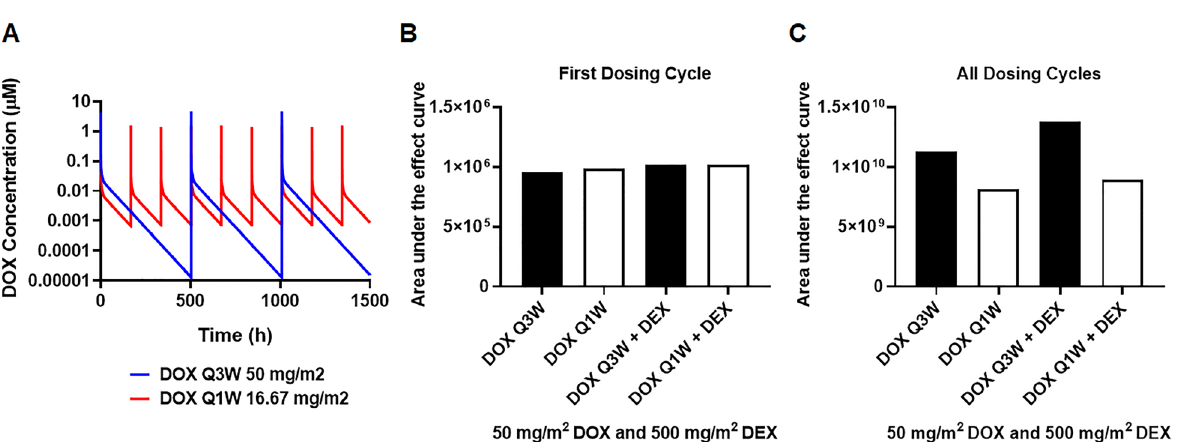
Figure 4. ( A , B ) Model simulations for doxorubicin (DOX) clinical pharmacokinetics over three dosing cycles ( A ) and one dosing cycle ( B ) at indicated dose levels. ( C , D ) Model simulations for dexrazoxane (DEX) clinical pharmacokinetics over three dosing cycles ( C ) and one dosing cycle ( D ) at indicated dose levels. ( E ) Area under the effect (cell viability) curves for 50 mg/m 2 DOX administered once every three weeks for three dosing cycles in the presence of varying DEX:DOX dose ratios as indicated. AUECs are represented as the ratio of AUEC DEX+DOX /AUEC DOX. . The shaded bar represents the optimal dose ratio that demonstrates maximum cardio protection with DEX.